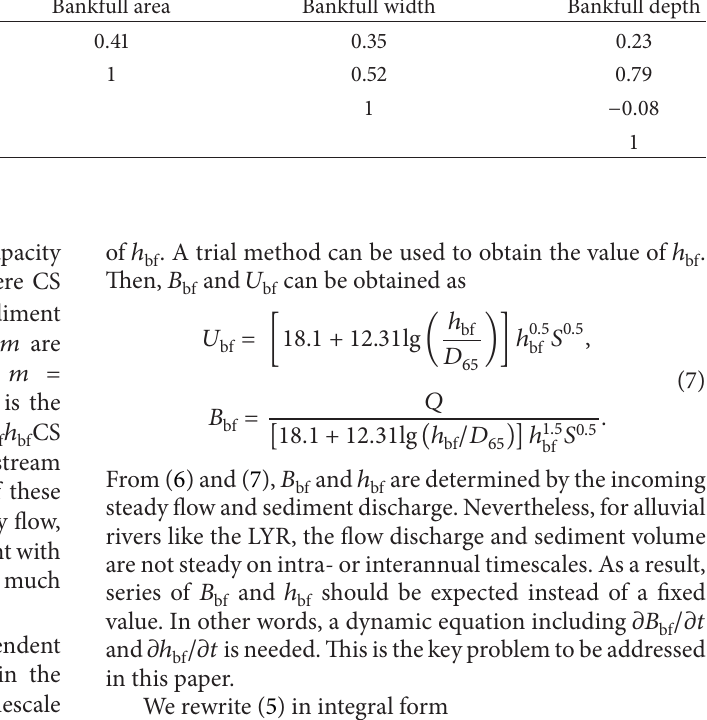
Table 2: Correlation matrix of the bankfull characteristics at Huayuankou Station. Bankfull discharge Bankfull area Bankfull width Bankfull